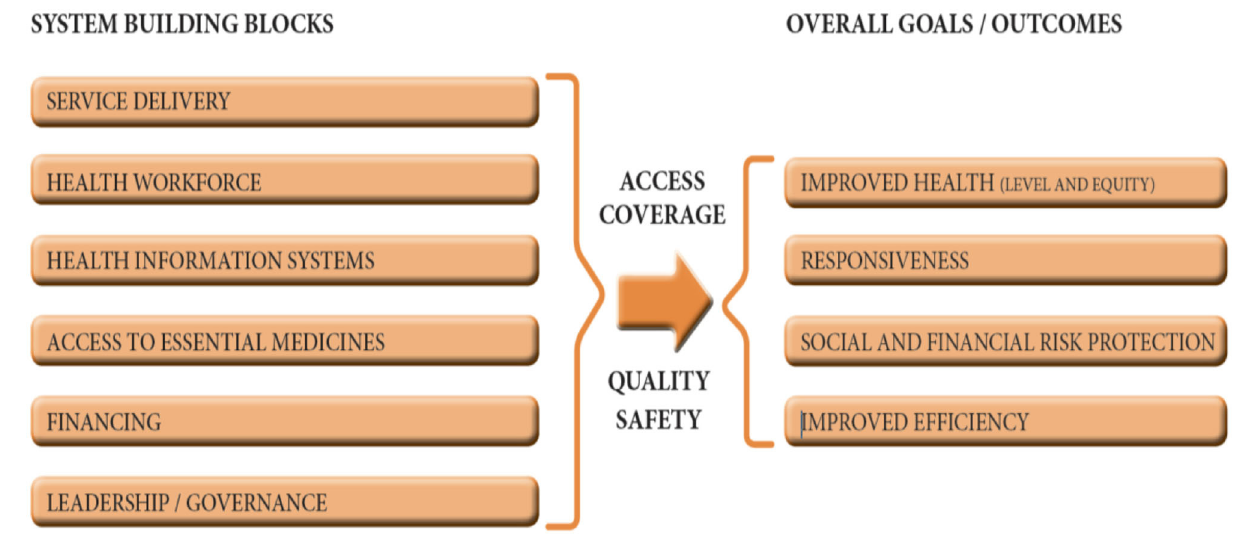
management systems (19). There are deep